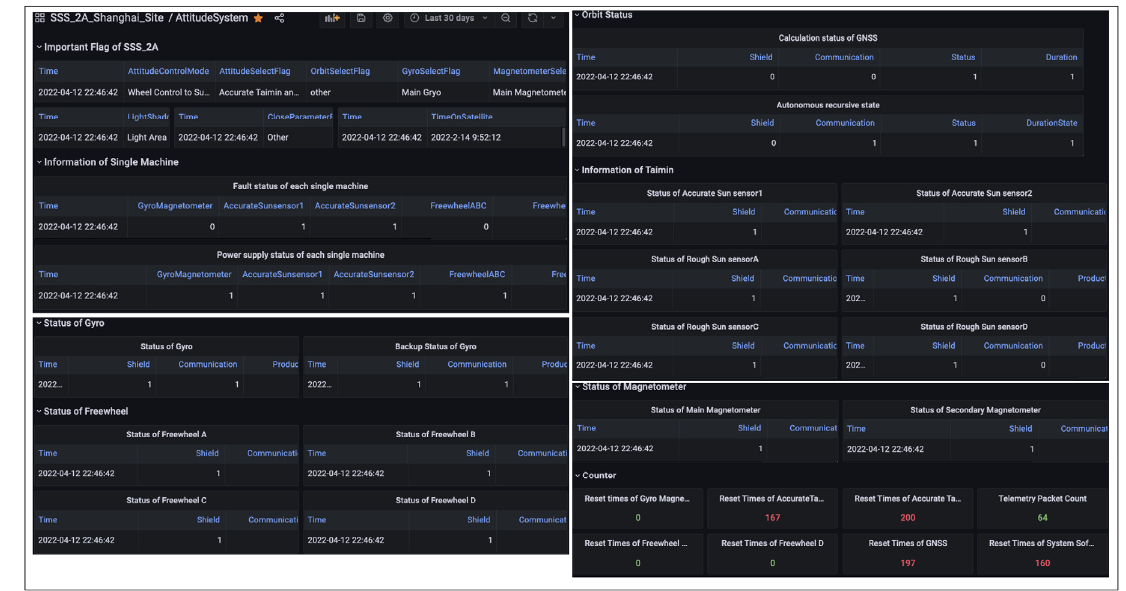
Figure 20. SSS-2A attitude control system data.